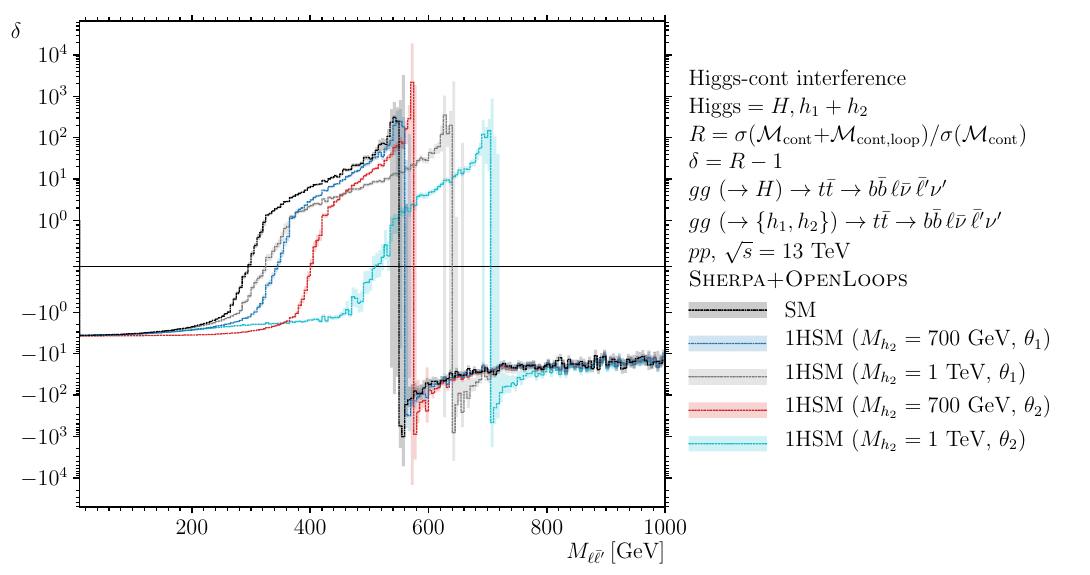
Figure 23 . M distributions of the relative deviation δ = R (cid:28) ¯ (cid:28) (cid:31) background without and with the virtual corrections in the SM and 1HSM ( M h ) for gg ( H, h 1 , h 2 ) t ¯ t b ¯ b (cid:21) ¯ ν ¯ (cid:21) (cid:31) ν (cid:31) in pp collisions at √ s = 13 TeV. Other details as θ 1 , θ 2 } → { } → → { in figure